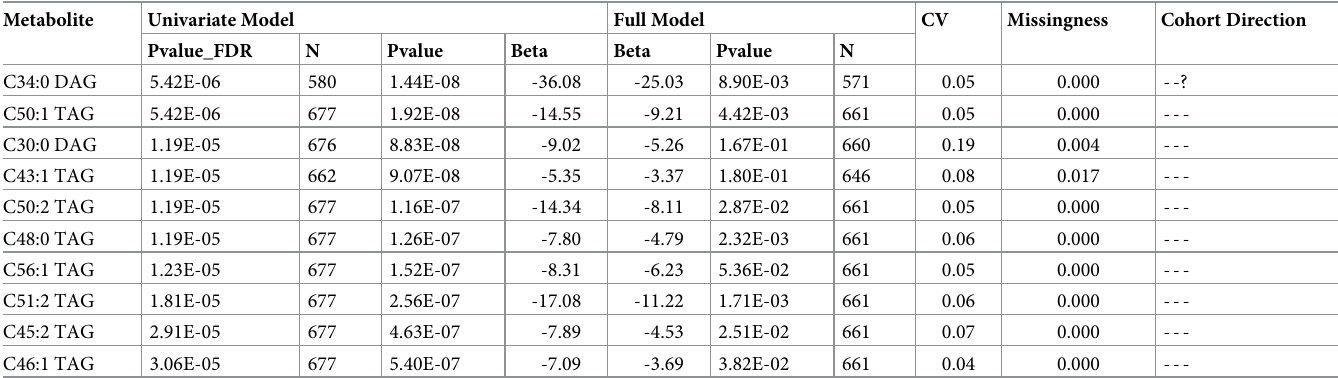
Table 2. Comparison of effect sizes between univariate and full models.